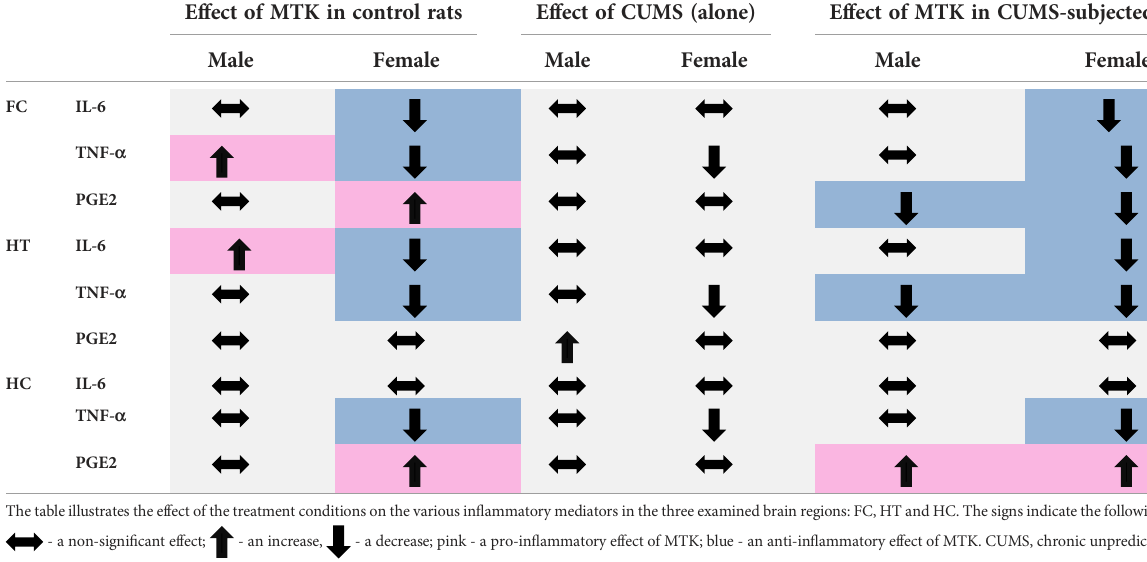
TABLE 2 Effect of MTK on brain in fl ammatory mediators ’ levels.